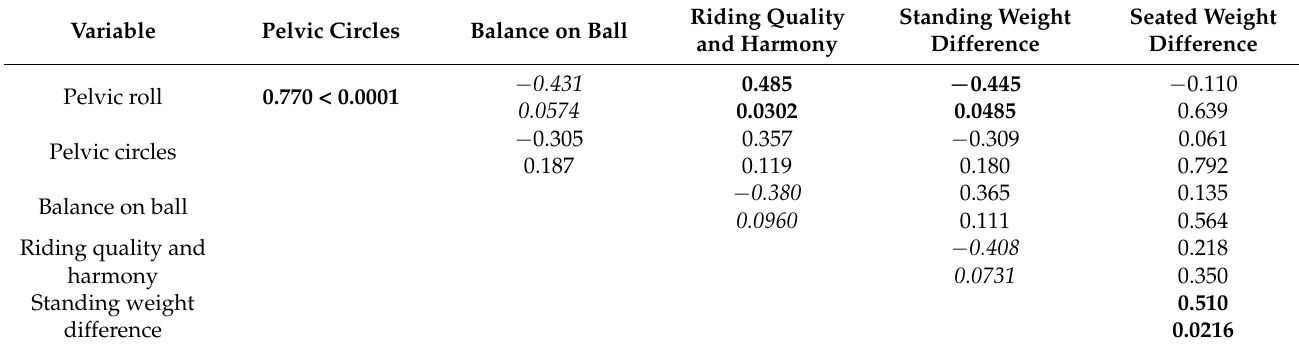
Table 1. Spearman rank order correlation coefficient and p value. Bolded values indicate statistically significant correla-